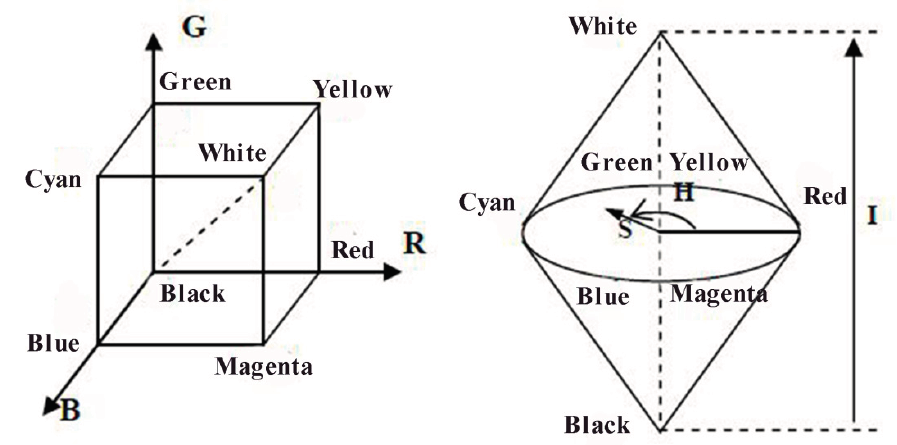
Figure 2. Schematic of the RGB color model ( Left ) and HSI color model ( Right ).